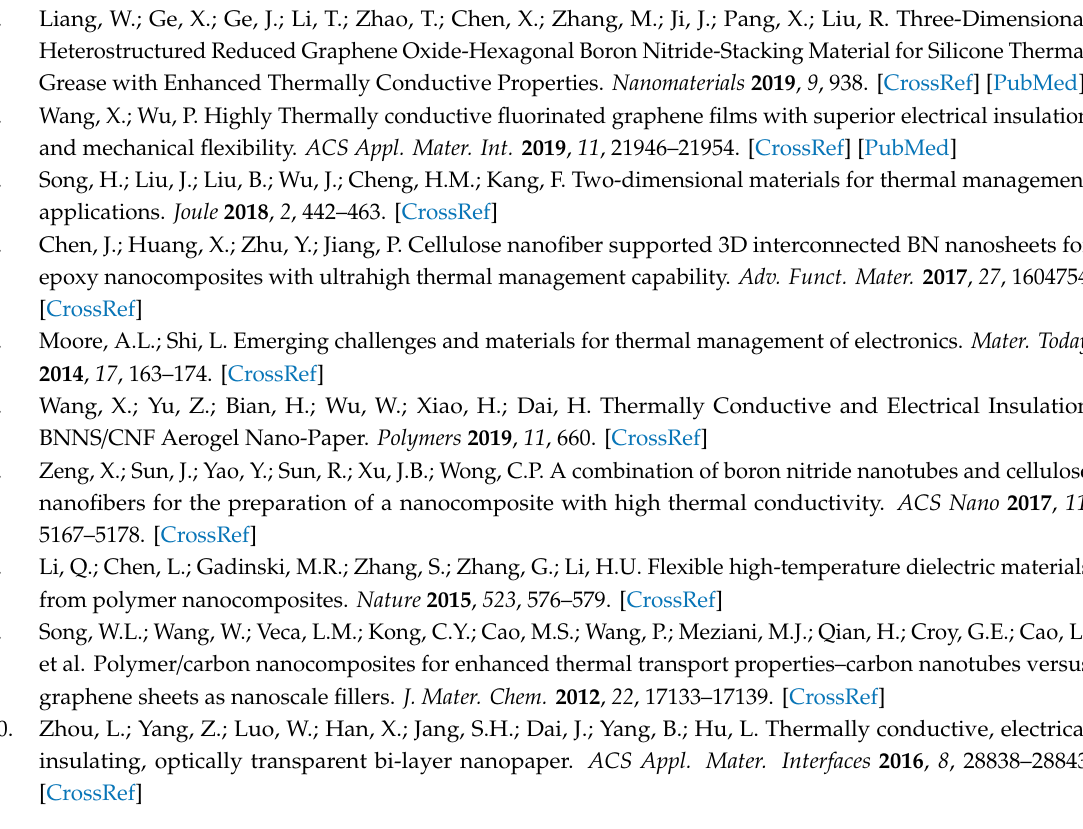
Figure S1: Schematic of exfoliation of h-BN, Figure S2: (a) Tyndall phenomenon of CNF. (b) and (c) Optical photographs of CNF aerogel, red arrows indicated the diameter and the thickness of the CNF aerogel were 65 mm and 7mm, Figure S3: (a) SEM image of commercially h-BN. (b) SEM image of exfoliated h-BN. (c) AFM topographic image of exfoliated h-BN. (d) The corresponding height distribution measured from AFM topographic data from Figure 2f, Table S1: Comparing the specific heat, thermal di ff usivity and density of h-BN / CNF composite films prepared by di ff erent methods (25 ◦